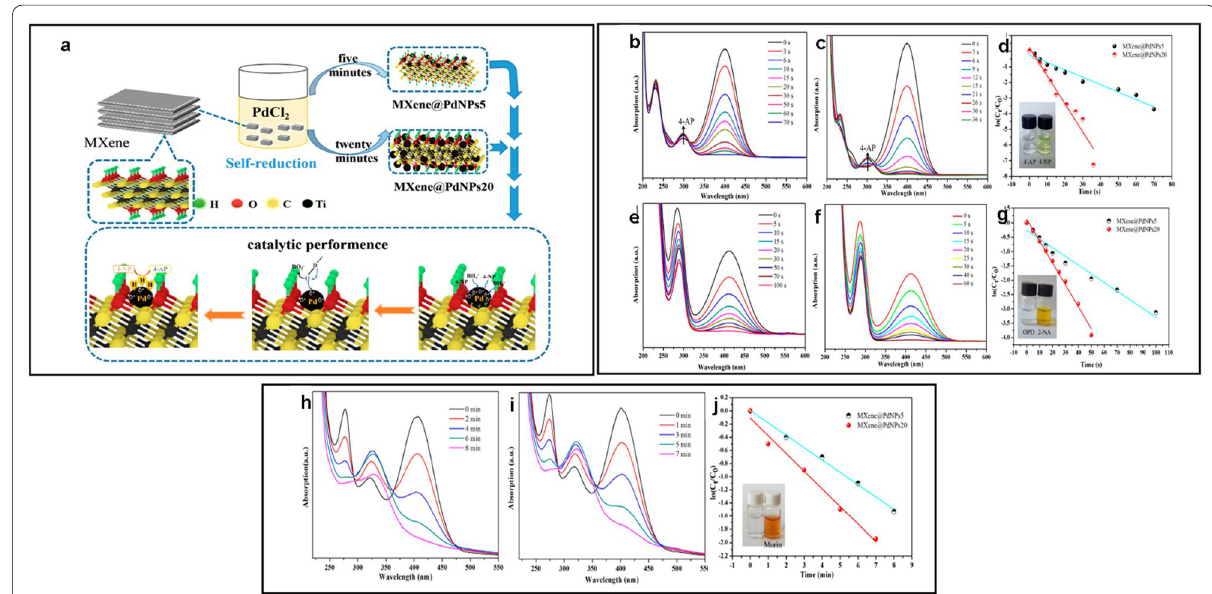
Fig. 7 a Scheme showing the self-reduction formation of Pd nanoparticles on MXene sheets. UV-spectra and the corresponding rate kinetic plots obtained using the Pd/MXene composite catalysts of b – d 4-nitrophenol (4-NP), e – g and nitroaniline (2-NA) and h – j morin. Reprint with permission